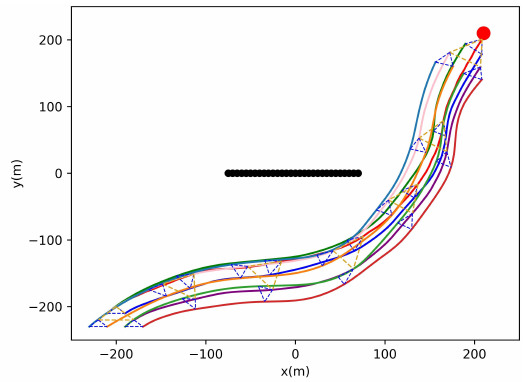
Figure 19. Trajectory of a full UGV double-layer triangle